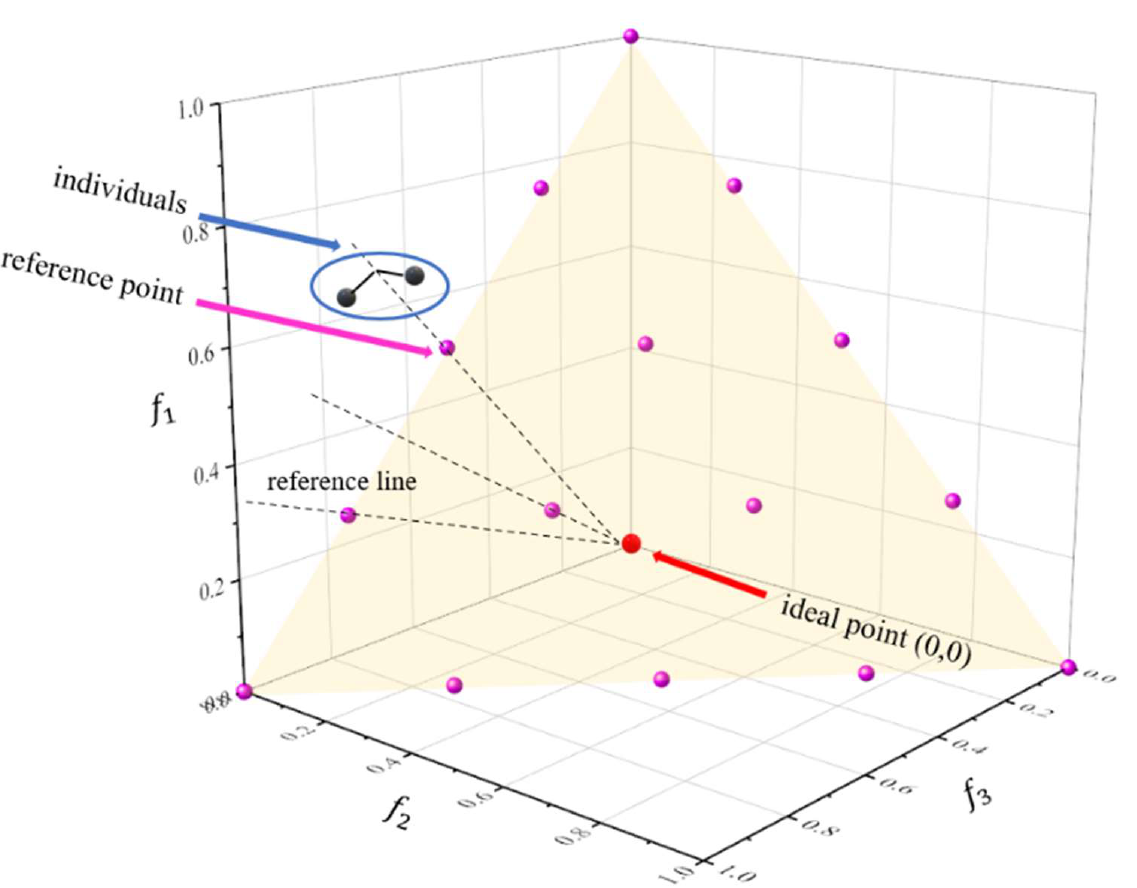
Figure 3. Association of individuals with reference points.